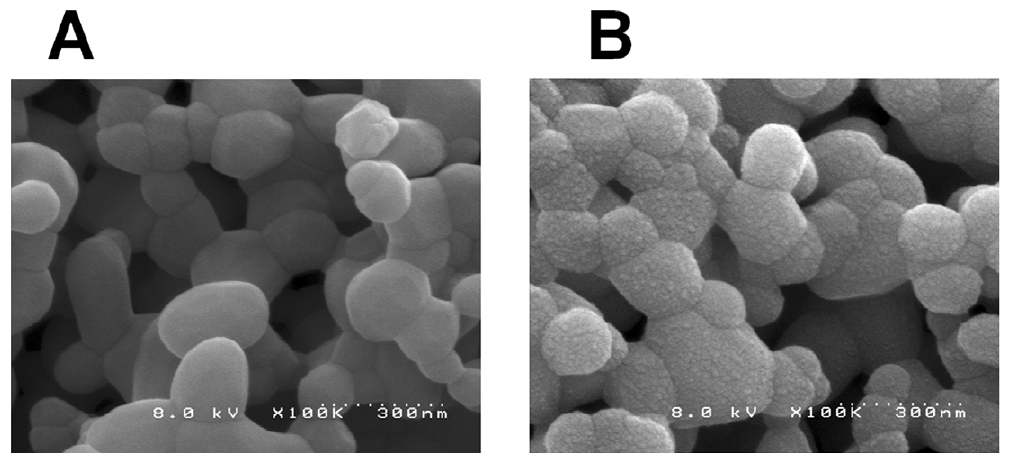
Figure 3. SEM images of control HAp surfaces. A: Untreated HAp particles; B: HAp particles after loading of cell culture fluid (virus- free).